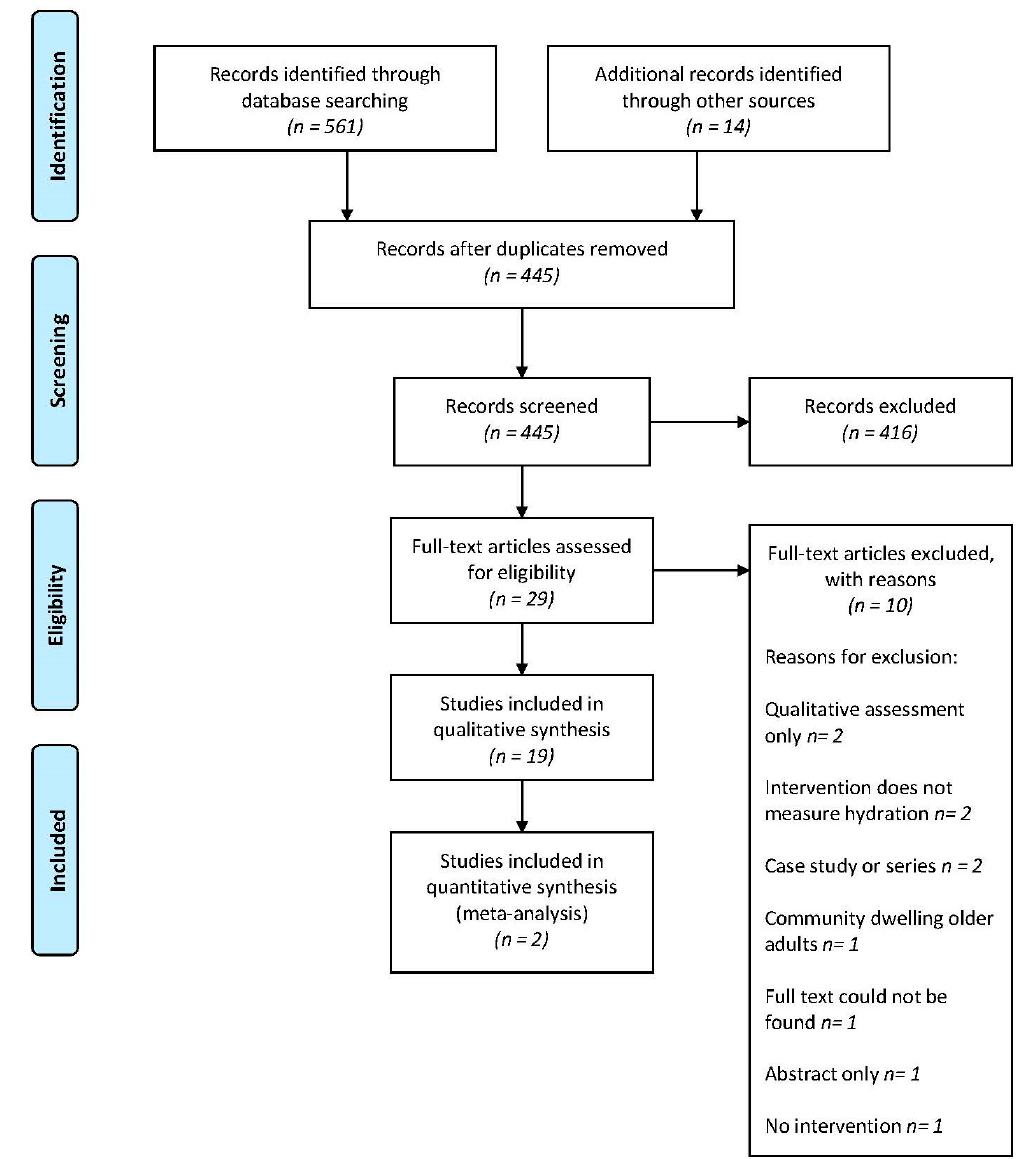
Figure 1. PRISMA Flow chart of study